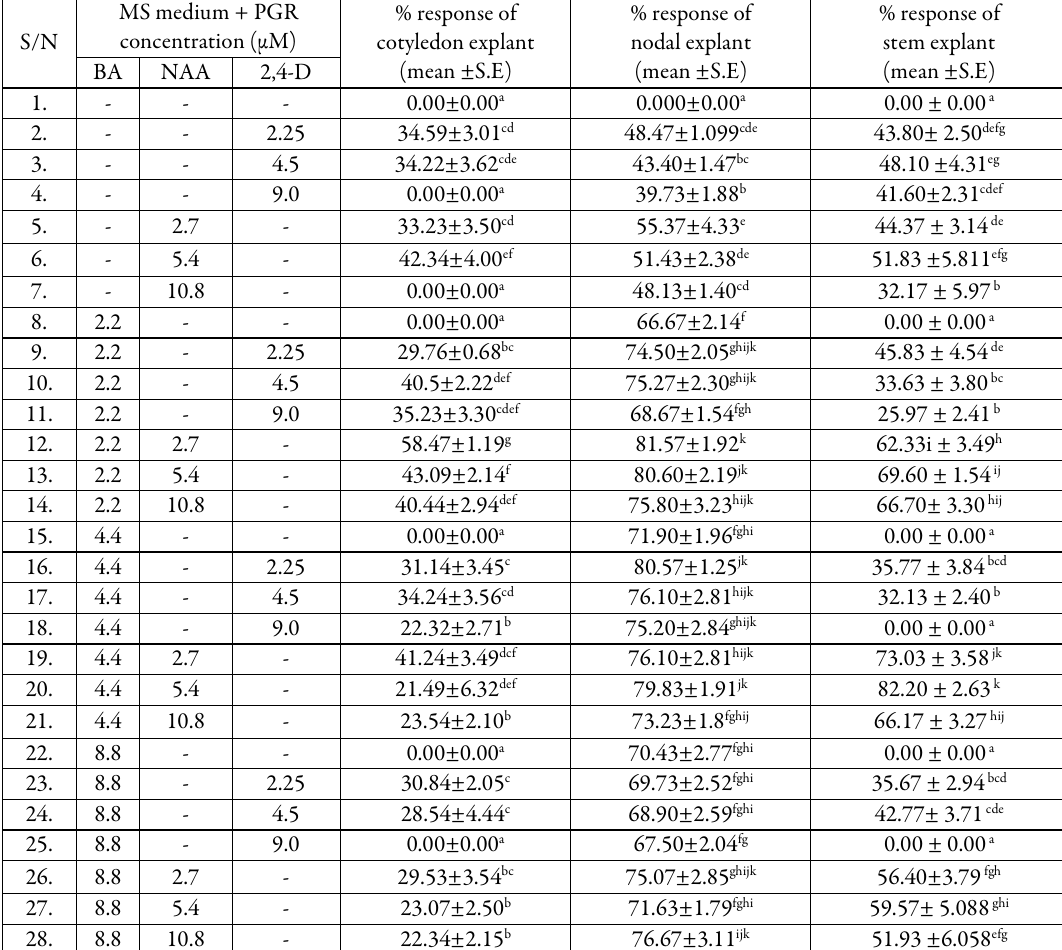
on callus formation from cotyledon, stem and nodal explants of E.